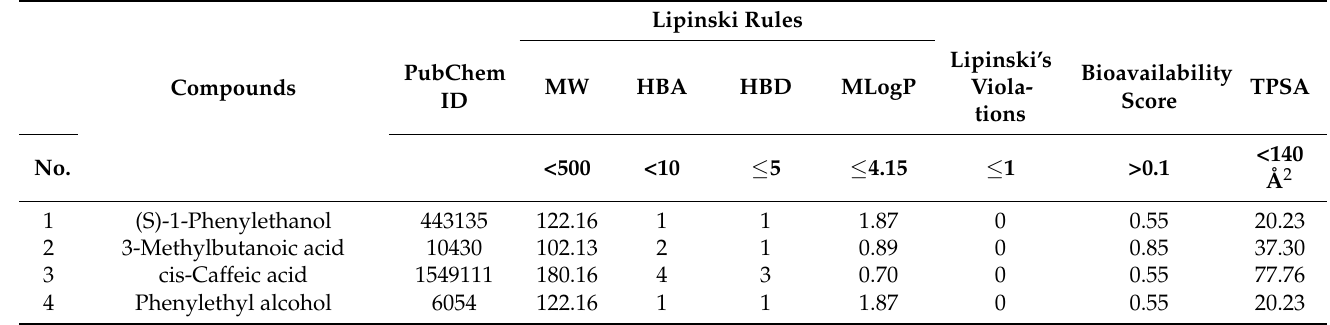
Table 1. The physicochemical properties of 82 chemical compounds in